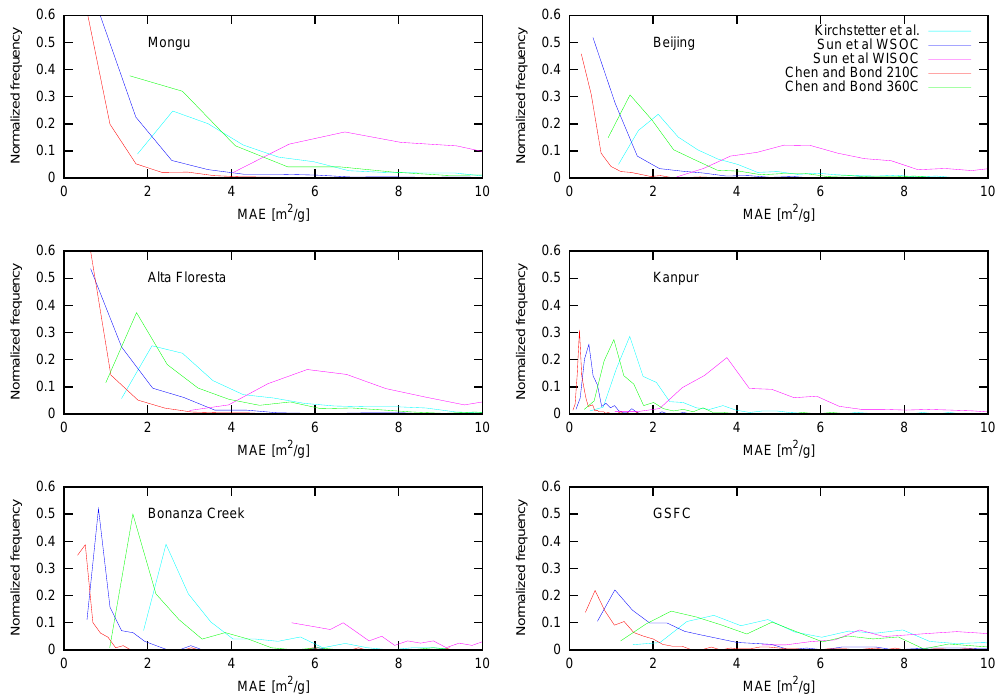
Fig. 6. Normalized frequency of mass absorption efficiency (MAE) of organic carbon in m 2 g − 1 , assuming the same imaginary index values for OC than in the Fig. 5. Following sites are included: Mongu, Beijing, Alta Floresta, Kanpur, Bonanza Creek, and